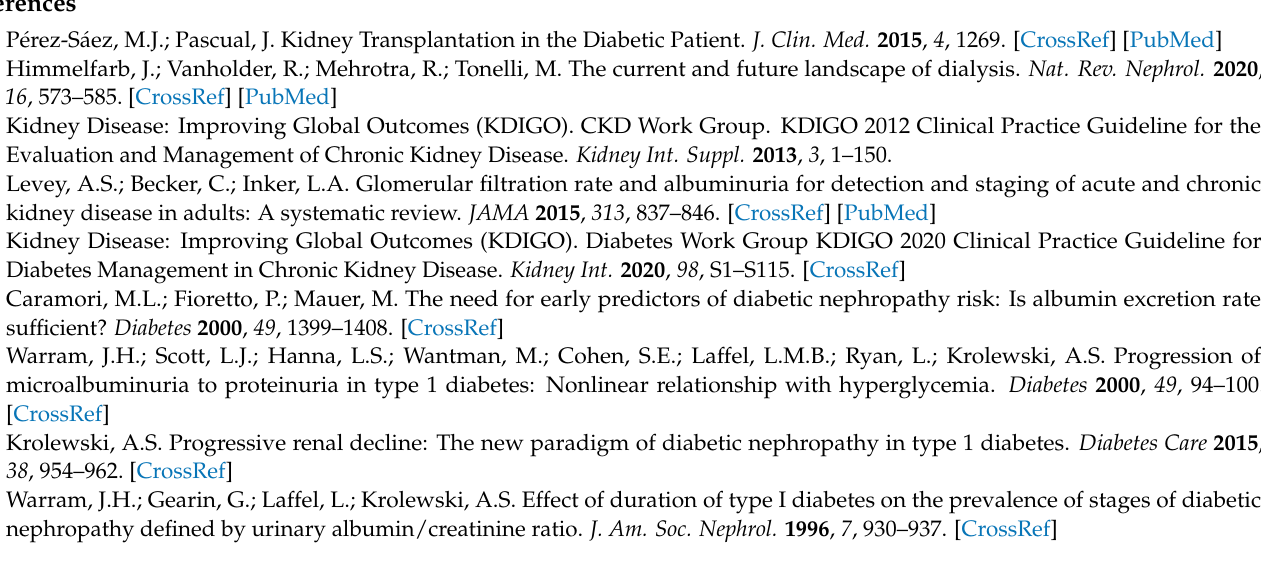
Table S1: The annotated metabolites associated with top dysregulated metabolite pathways between the T1D, T1D-DN1, and T1D-DN2